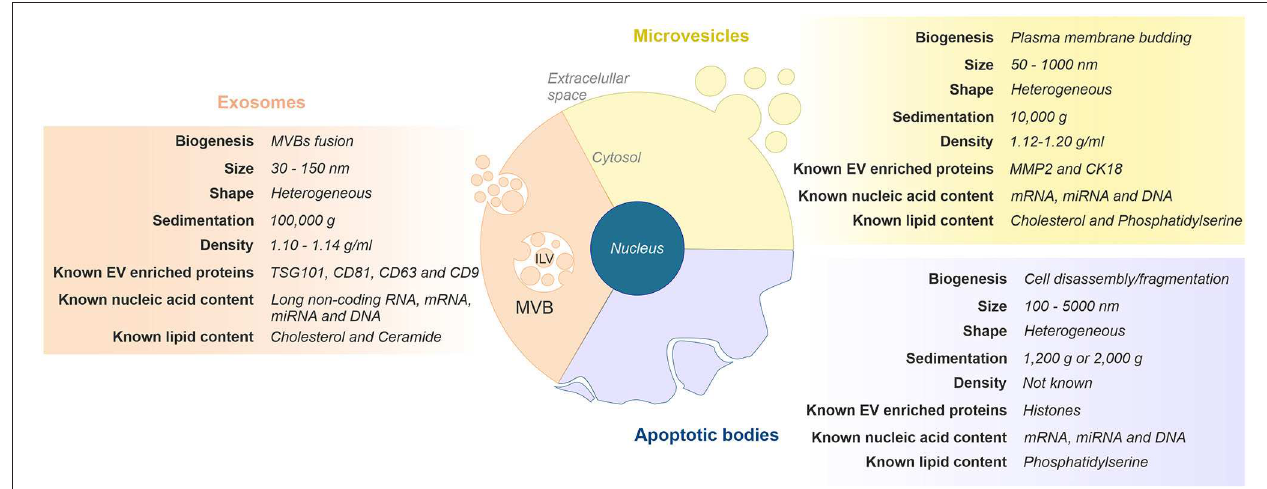
FIGURE 1 | Classification and representative characteristics of extracellular vesicles (EVs) subtypes. Extracellular vesicles can be classified in three main subgroups based on their size and cellular biogenesis: exosomes, microvesicles, and apoptotic bodies. Exosomes are formed via the endosomal pathway and are released upon fusion of MVBs with the plasma membrane. Microvesicles are generated by the outward budding and fission of the plasma membrane. Apoptotic vesicles are released upon cell fragmentation during apoptotic cell death. ILV, intraluminal vesicle; MVB, multivesicular